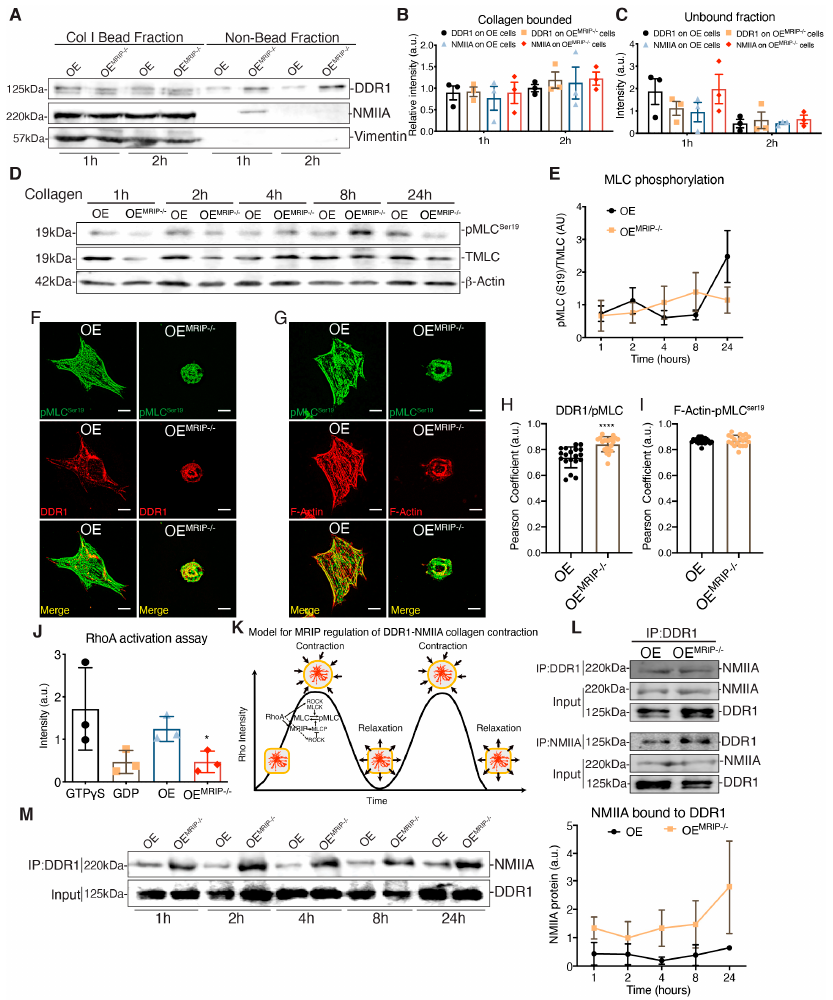
Figure 7. MRIP ablation enhances DDR1-NMIIA association but disrupts the myosin contraction cycle. ( A ) Collagen bead-bound fractions were prepared from OE and OE MRIP- / - cells, which were immunoblotted for DDR1, NMIIA, and vimentin. Relative amounts of DDR1 and NMIIA in collagen- bound, ( B ) and unbound ( C ) fractions were quantified by densitometry of immunoblots, n = 3. ( D ), Whole-cell lysates of cells cultured on fibrillar collagen-coated tissue culture plates were immunoblotted for phospho-MLC Ser19 (#3675, CS), MLC #3672S, CS), and β -actin. ( E ) Quantification of pMLC Ser19 / MLC by densitometry of immunoblots, n = 3. Cells were cultured on collagen for 3 h and co-immunostained for DDR1 (C-6: sc-374618) and pMLC Ser19 (#3671S, CS), ( F ), or for pMLC Ser19 and F-actin, ( G – I ). Pearson coe ffi cients were obtained by quantification of the fluorescent images using the colocalization2 plug-in in Fiji. n = 3, scale bar, 10 µ m. ( J ) Cells were plated on collagen for 3 h, active GTP-RhoA was accessed by pull-down assay and measured by densitometry of GTP-RhoA / Total-RhoA on immunoblots, n = 3. ( K ) Temporal regulation of MRIP dependent myosin contractility. MRIP binds MLCP and RhoA and targets them to myosin enabling dephosphorylation of the MLC and consequently myosin contraction cycle. ( L ) DDR1 (C-6: sc-374618) or NMIIA (BT-564) was co-immunoprecipitated from cell lysates of cells cultured on fibrillar collagen. Immunoprecipitates were then immunoblotted for NMIIA or DDR1 respectively. ( M ) DDR1 (C-6: sc-374618) was immunoprecipitated from cell lysates of cells cultured on fibrillar collagen for indicated time points and immunoblotted for NMIIA. The immunoprecipitates were immunoblotted for NMIIA and DDR1, respectively. Quantification of NMIIA bound to DDR1 by densitometry of immunoblots, n = 2. Data are reported as mean ± SD for H and I or as mean ± SEM, n = 3. * p < 0.05, **** p <